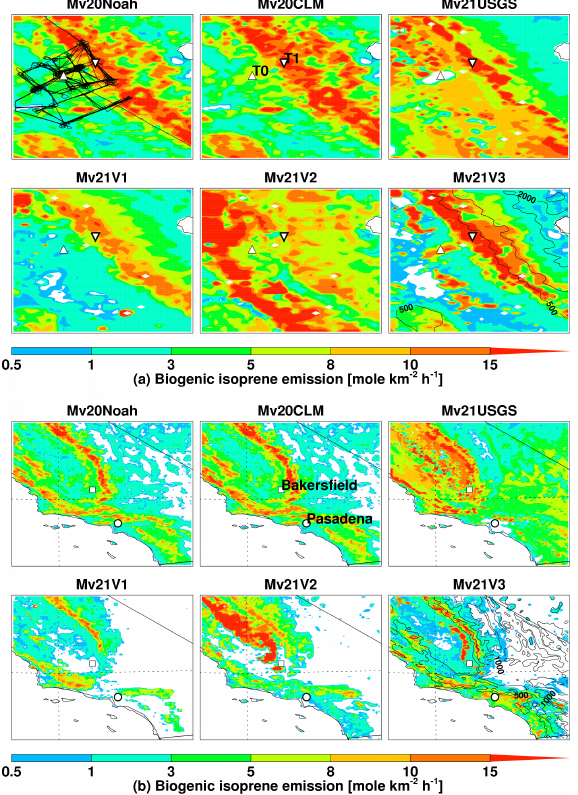
Figure 8. (a) Spatial distributions of biogenic isoprene emissions around the CARES observational sites T0 and T1 (the black box shown in Fig. 7) estimated in the six simulations as listed in Table 1. The CARES G-1 flight tracks below 1km (black line) during June 2010 are also shown with the Mv20Noah result; the terrain height is also shown as the black contour lines with the Mv21V3 result. (b) Same as panel (a) except around the CalNex observational sites Bakersfield and Pasadena (the red box shown in Fig. 7).